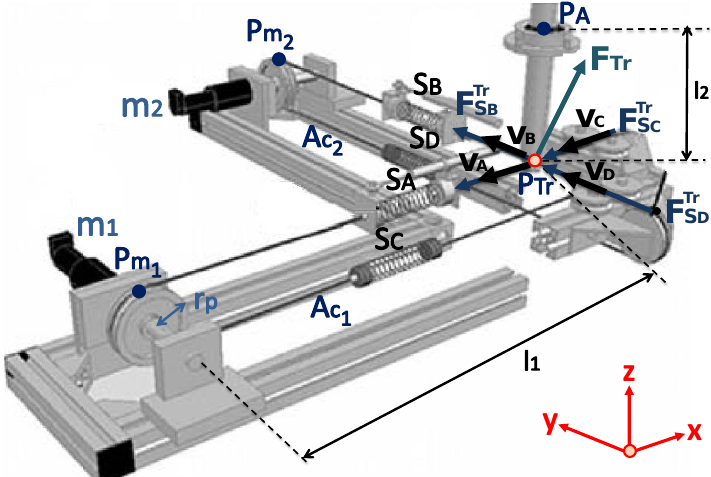
Figure 3. Drive system of the UHP rehabilitation